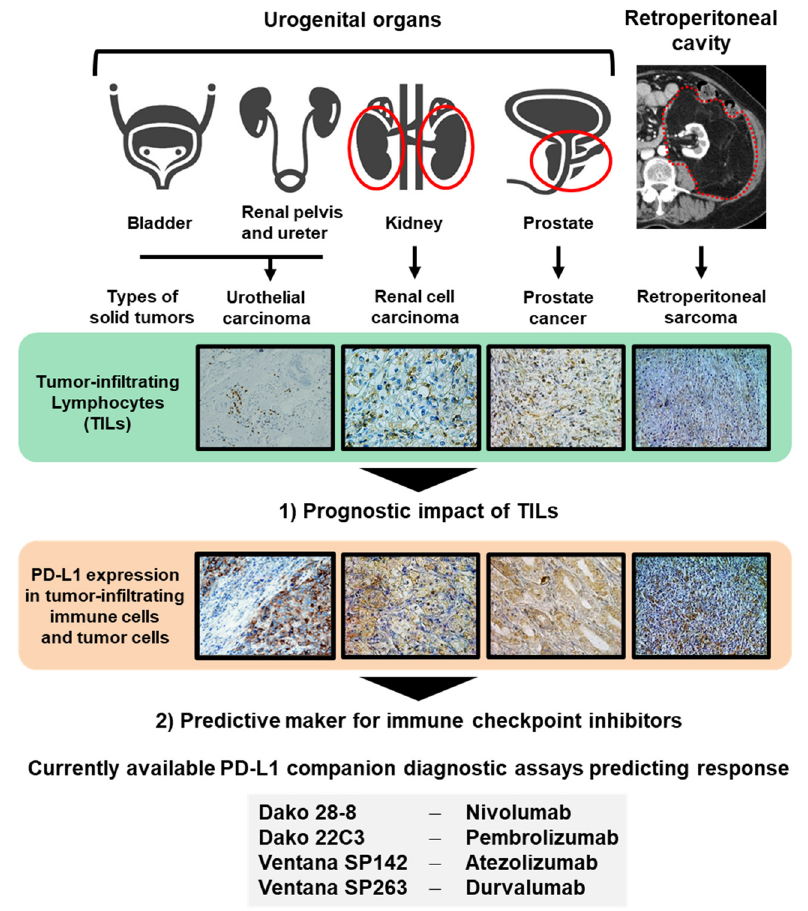
Figure 1. Two topics discussed in this review. Urologists should handle several malignancies arising from different organs, including the bladder, renal pelvis, ureter, kidney, prostate, and tissues of the retroperitoneal cavity. In this review, we discuss two topics: ( 1 ) the prognostic impact of tumor-infiltrating leukocytes (TILs) and ( 2 ) predictive markers for immune checkpoint inhibitors to shed light on lymphocyte migration in four solid tumors, the urothelial carcinoma, renal cell carcinoma, PCa, and retroperitoneal sarcoma. Currently available PD-L1 companion diagnostic assays predicting response to immune checkpoint inhibitors are shown.